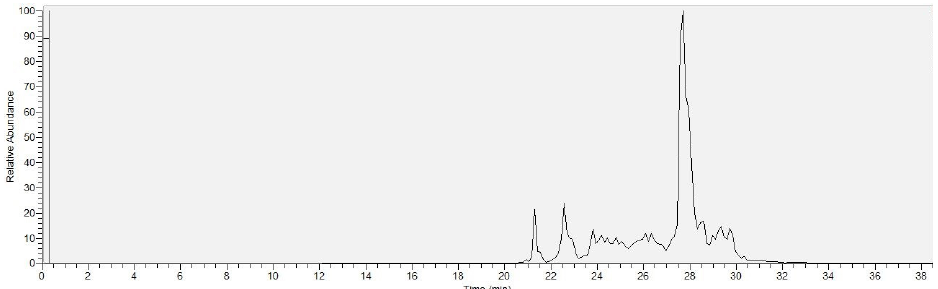
Figure 1. The TIC of the SIM mode measurement of B. velezensis strain SZMC 24980.